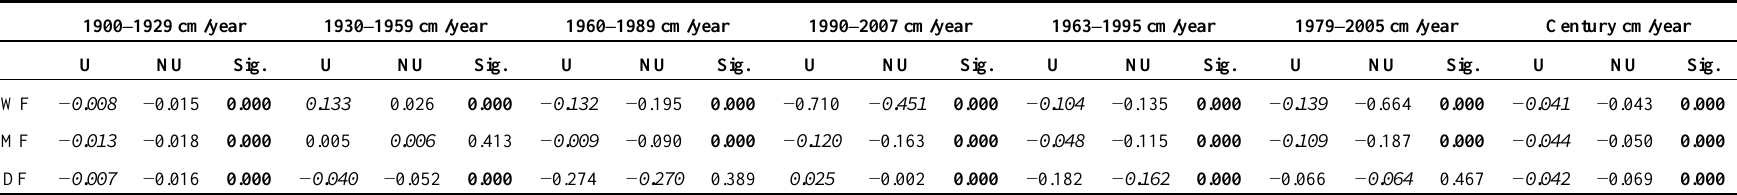
Table 10. The 270 m grid cell yearly average total precipitation trends for each period and its corresponding urban vs. non urban T test significance values.